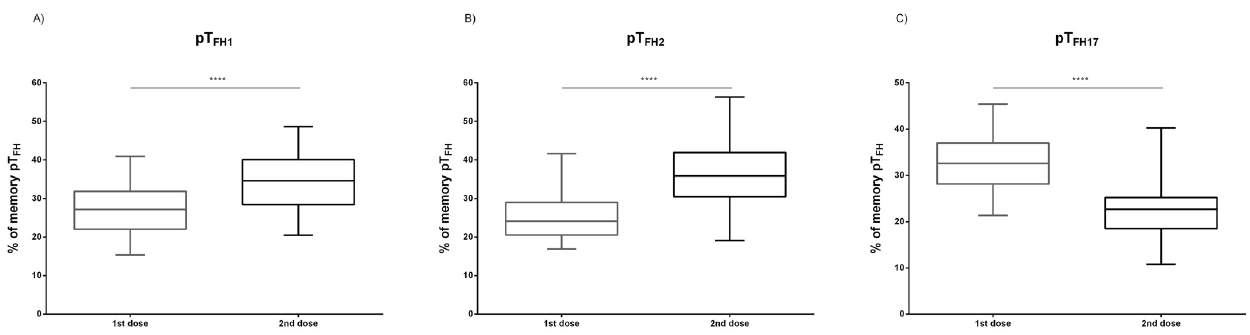
Figure 4. Memory peripheral T follicular helper subset assessment. The frequency of memory peripheral T Follicular helper 1 (pT FH1 ) ( A ), memory peripheral T Follicular helper 2 (pT FH2 ) ( B ), and memory peripheral T Follicular helper 17 (pT FH17 ) ( C ) after the first and the second doses (1st and 2nd dose, respectively) are depicted. U-Mann–Whitney test was used to compare medians in ( A – C ), **** ( p < 0.0001).